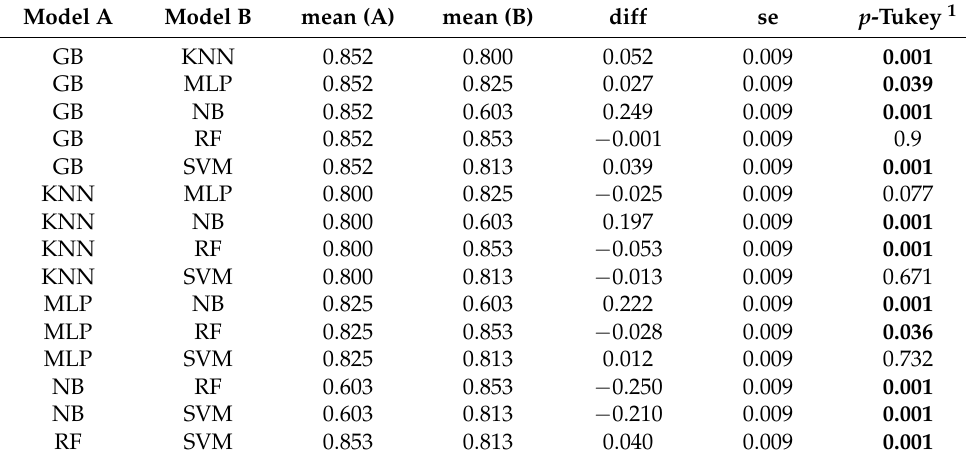
Figure 5. ROC curve plot of each classification model trained on original-dataset. The AUROC scores were achieved by the models during stress prediction of the test dataset from the original-dataset. Table 4. Statistical Evaluation of the machine learning models.